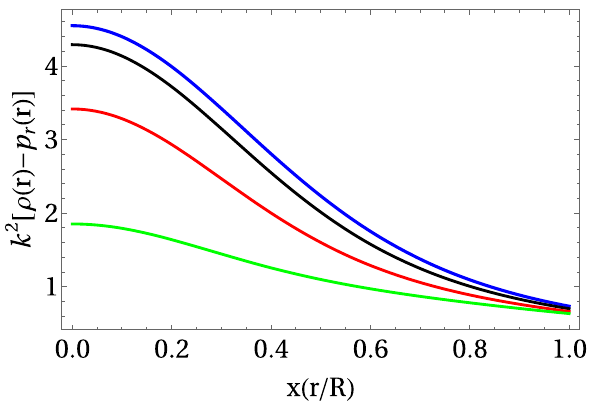
Fig. 14 k 2 [ ρ( r ) − p t ( r ) ] for Model II for compact factors: 0.38 (blue line), 0.39 (black line), 0.40 (red line) and 0.407 (green line)